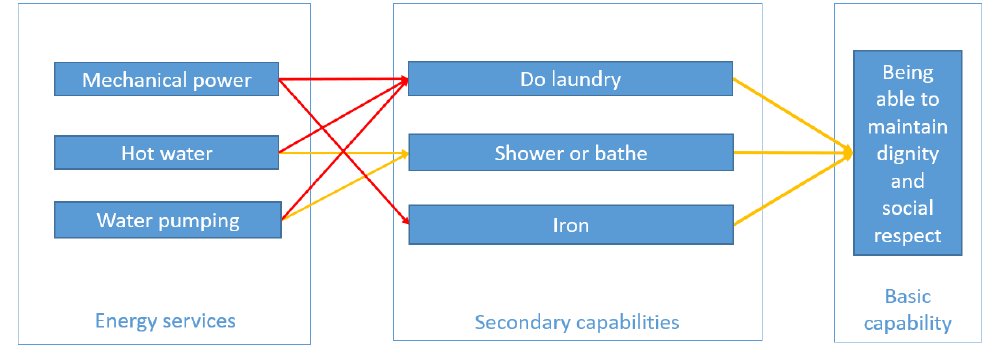
Figure 7. Connections between energy services, secondary capabilities, and ability to maintain dignity and social respect.